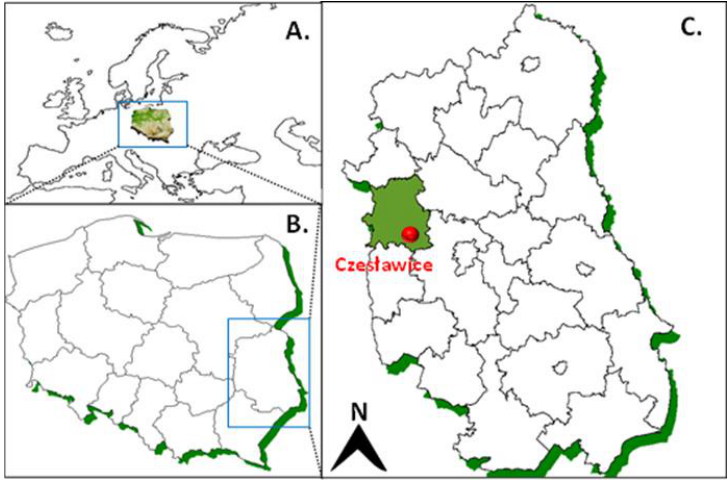
Figure 1. Location of the research area: ( A ) location of Poland against the background of Europe; ( B ) location of the Lublin region in Poland; and ( C ) location of the “Czesławice” farm in the Lublin region. Experimental plots were located on a lessive soil belonging to the second quality class [47,48]. Soil grain size composition was as follows: fraction 1.0–0.1 mm—medium sand (4%); fraction 0.1–0.02 mm—fine sand—coarse dust (52%); fraction 0.02–0.002 mm—fine dust (35%); and fraction <0.002 mm—colloidal clay (9%). The plots were established in triplicate (the area of a single plot was 3 m 2 ) and fertilized for three years (in the fall)